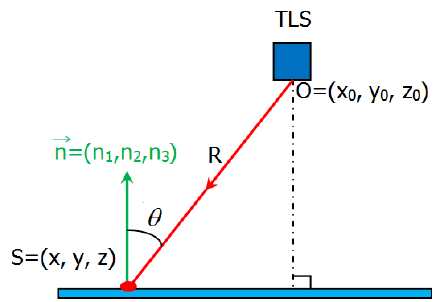
Figure 2. Geometric relationship of scan time. n(n (cid:2869) , n (cid:2870) ,n (cid:2871) ) is the normal vector estimated by computing the best-fitting plane to a neighborhood of points surrounding the point of interest S(x,y, z) . O(x (cid:2868) , y (cid:2868) ,z (cid:2868) ) is the scanner center. θ is the incidence angle and R is the distance.